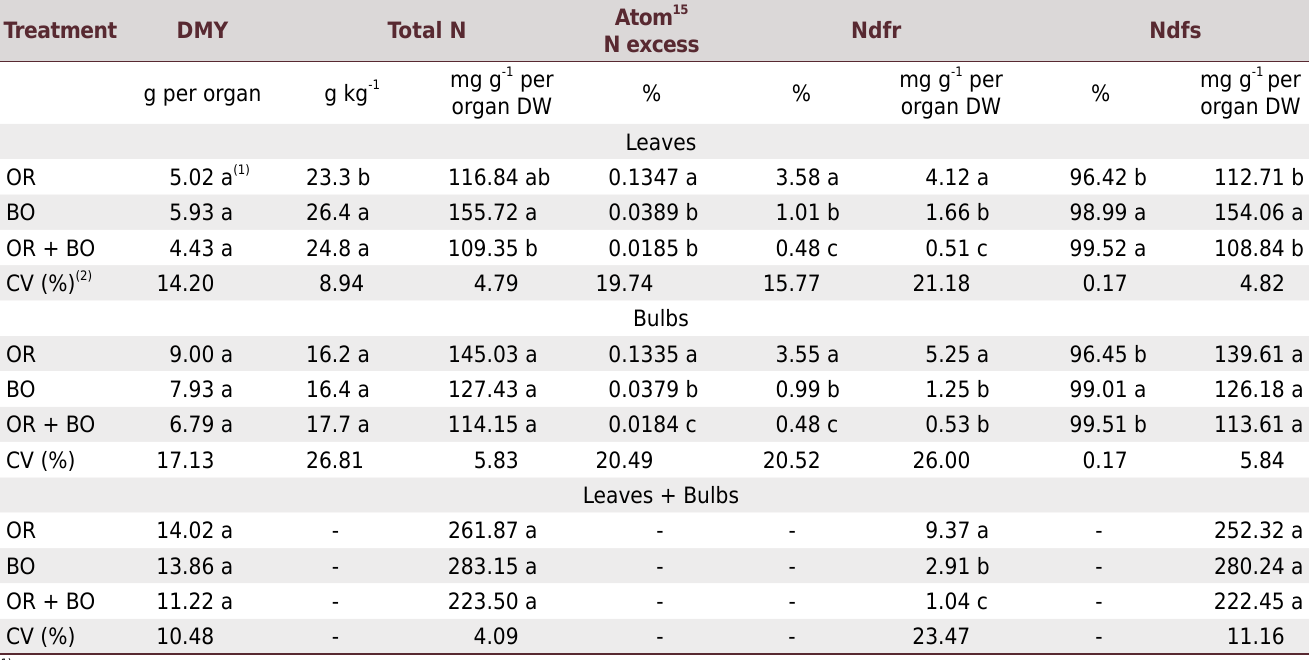
Table 2. Dry matter yield (DMY), total N, atom 15 N excess, N derived from residue (Ndfr), and N derived from other sources (Ndfs) in leaves, bulbs, and leaves + bulbs of onion plants collected at harvest time (83 days after residue addition), in response to soil treatment with oilseed radish (OR), black oat (BO), and oilseed radish + black oat (OR + BO) residues